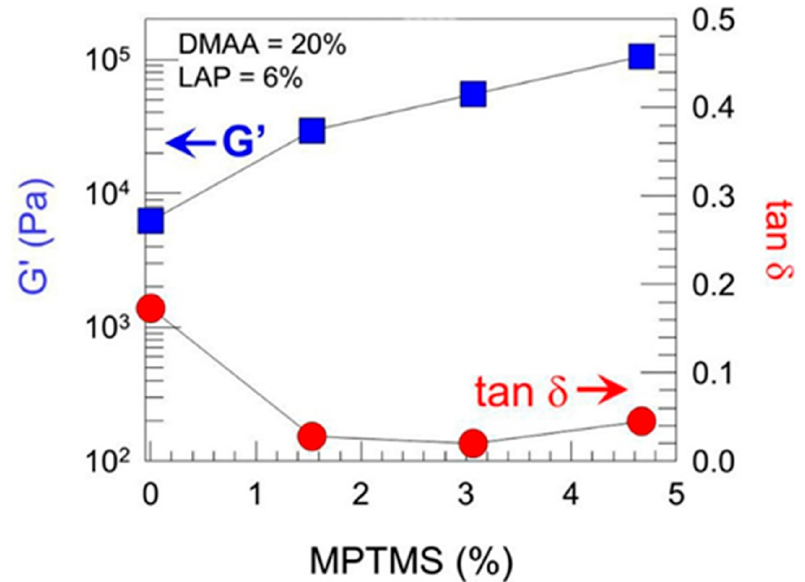
Figure 9. Oscillatory shear rheology of di ff erent zones of a soft − sti ff hybrid gel, where G ′ and the loss tangent tan δ are plotted as a function of MPTMS content with DMAA held constant at 20% and LAP at 6% [10].